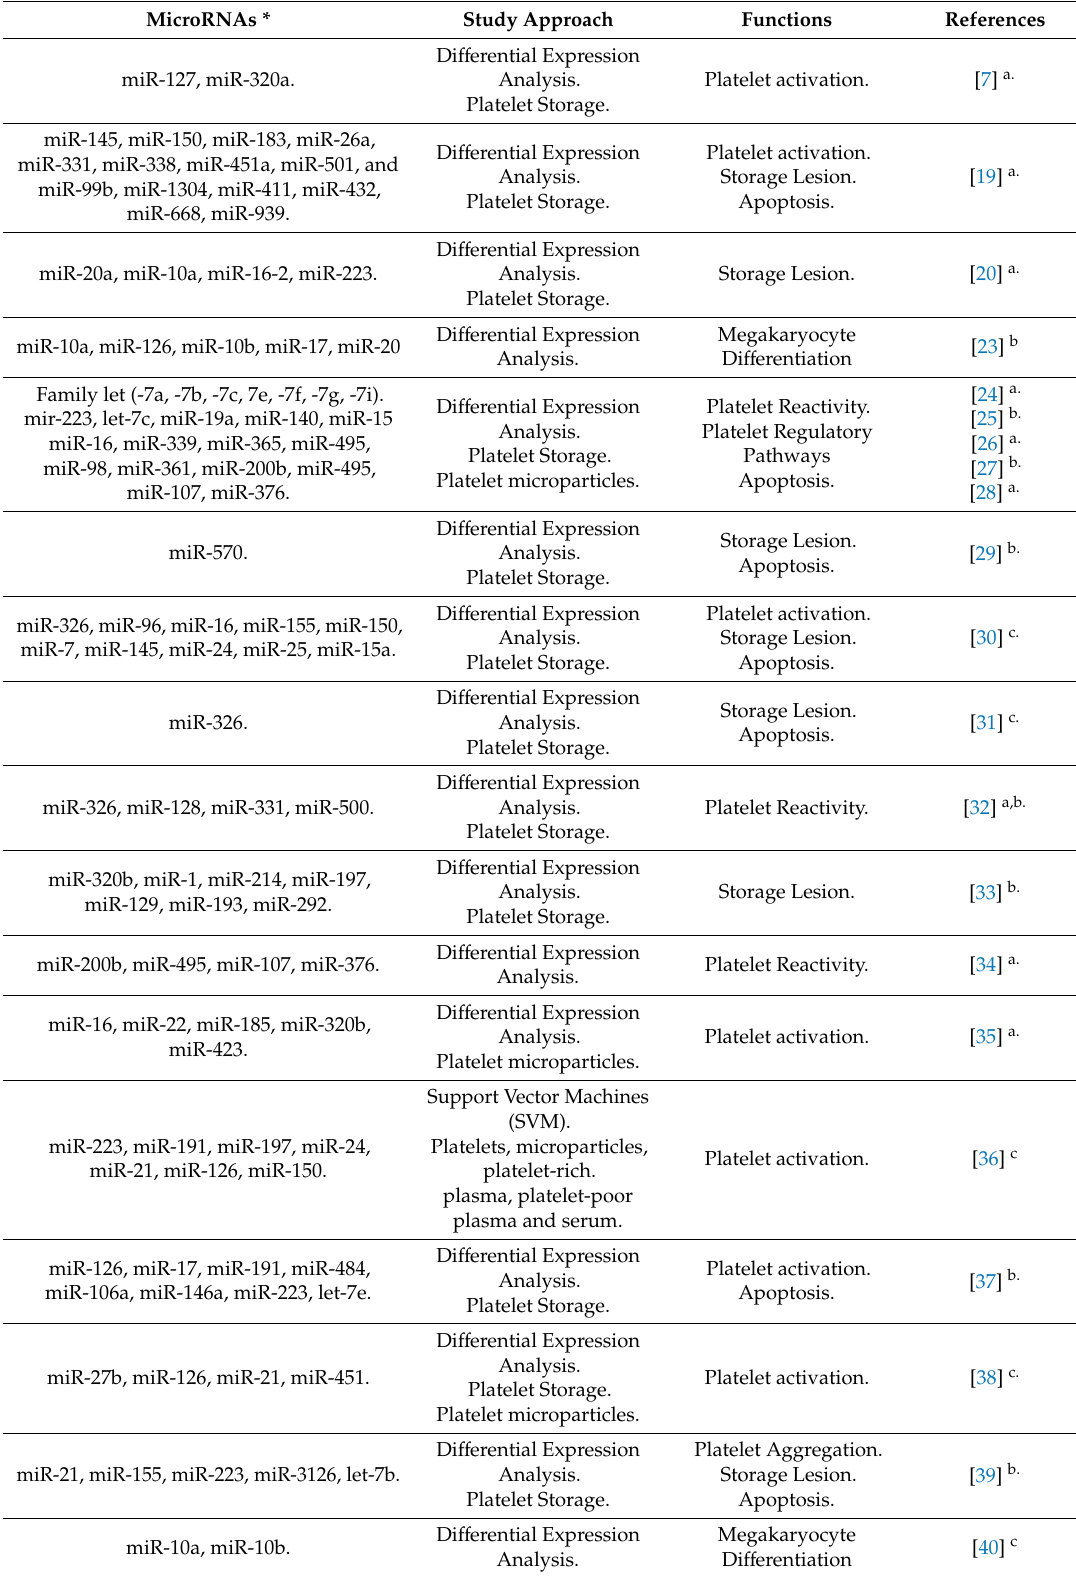
Table 1. A list of miRNAs and their main functions in